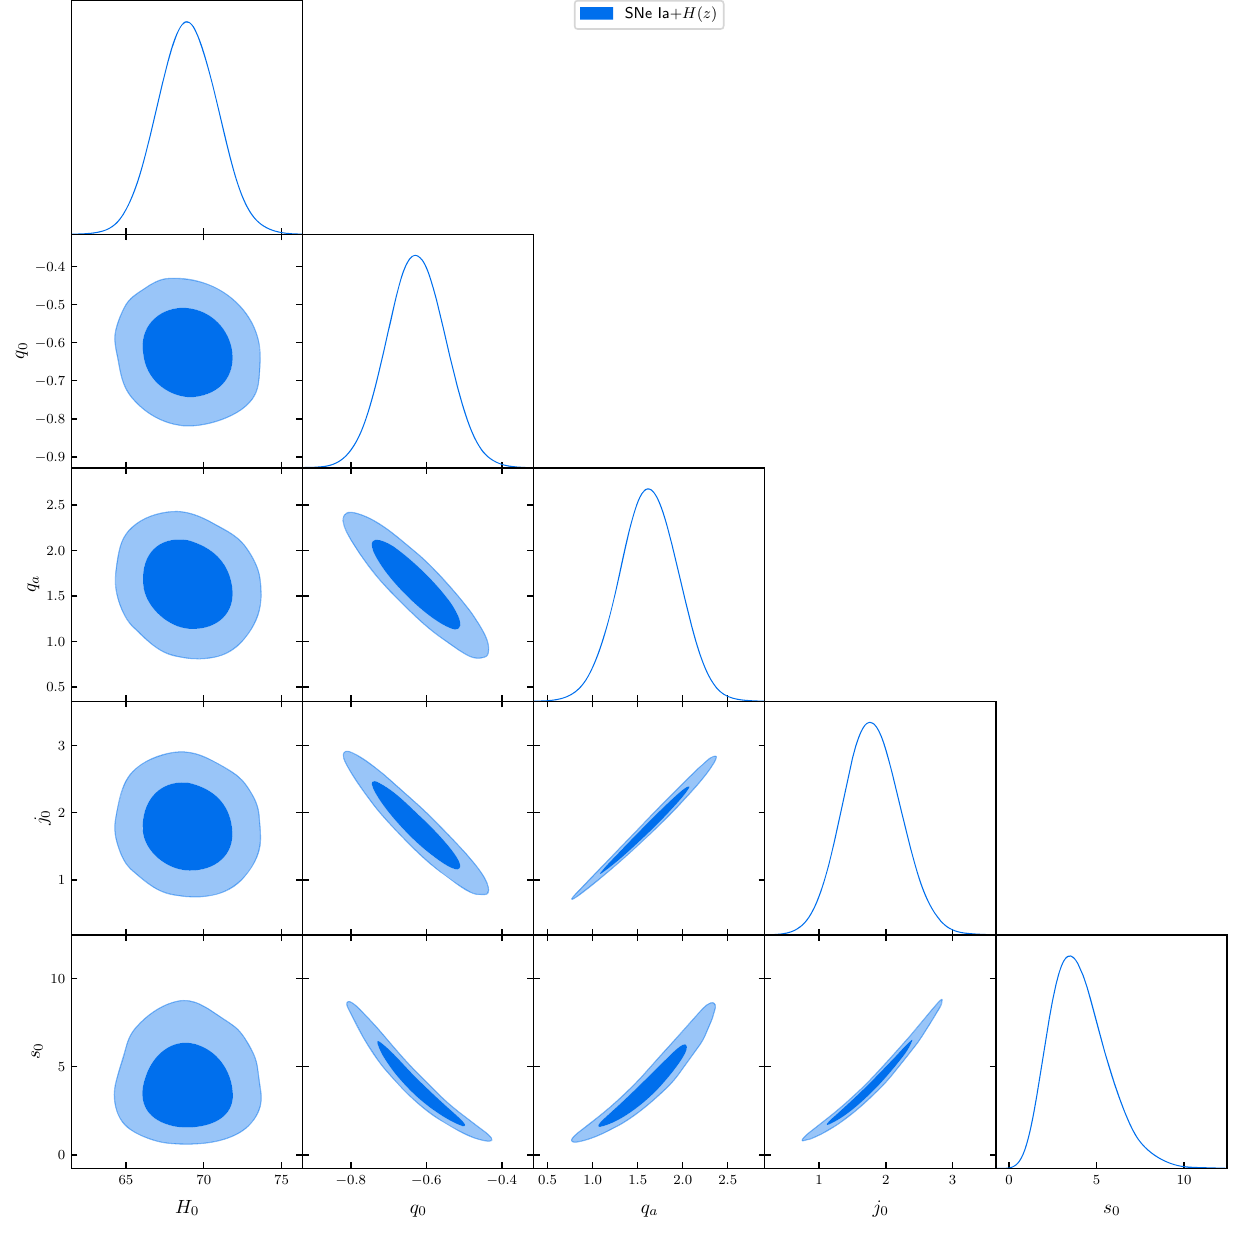
Fig. 4 M2: q ( z ) = q 0 + q a ( 1 − a